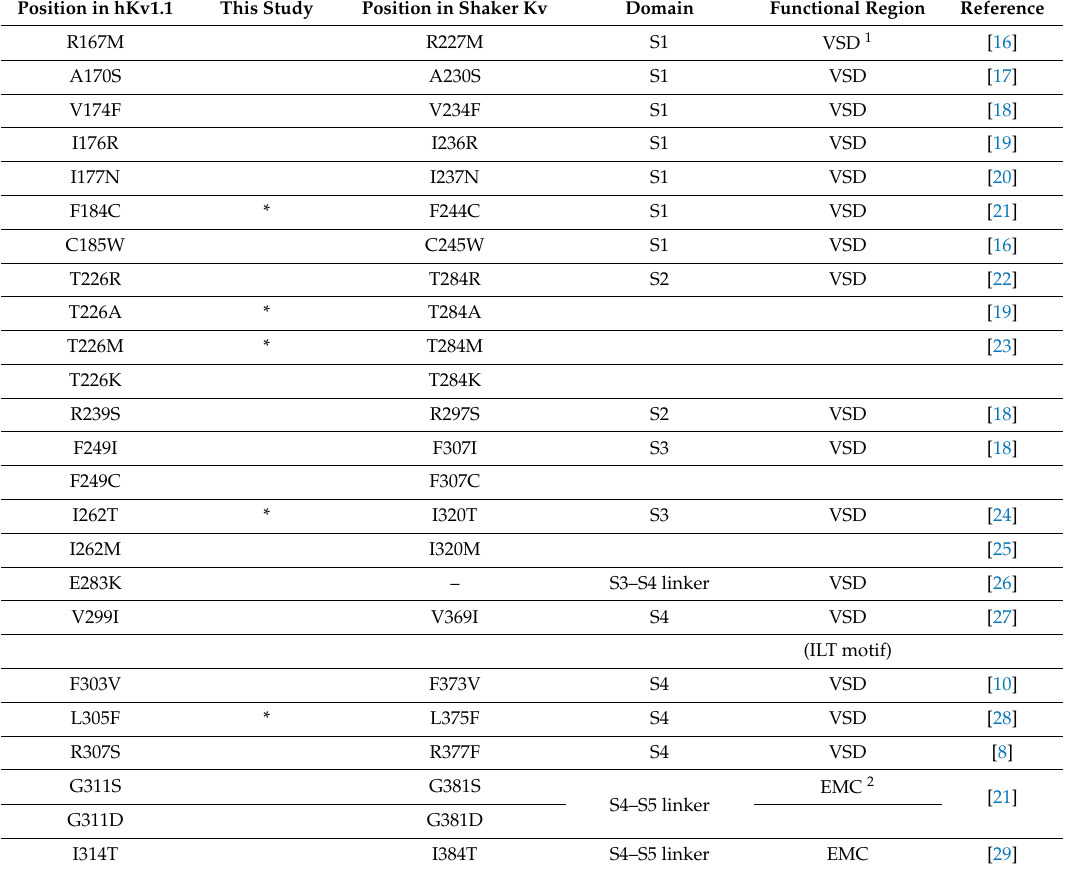
Table 1. List of mutations in Kv1.1 linked to episodic ataxia type 1. Mutants with star * have been studied in this